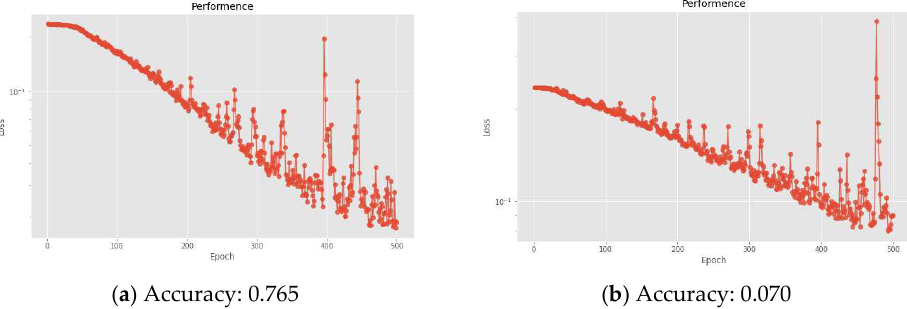
Figure 12. Loss function and accuracy of various hidden layer settings of DNN: ( a ) 12 layers. ( b ) 20 layers.